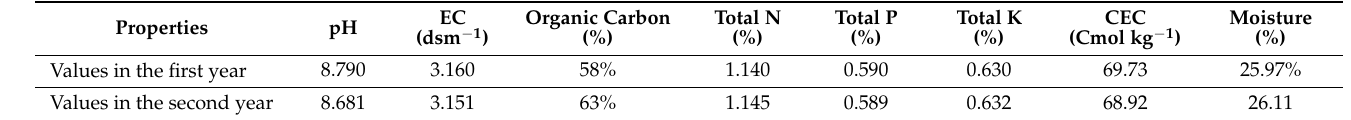
Table 9. Physical and chemical properties of Farmyard manure used in the current experiment.